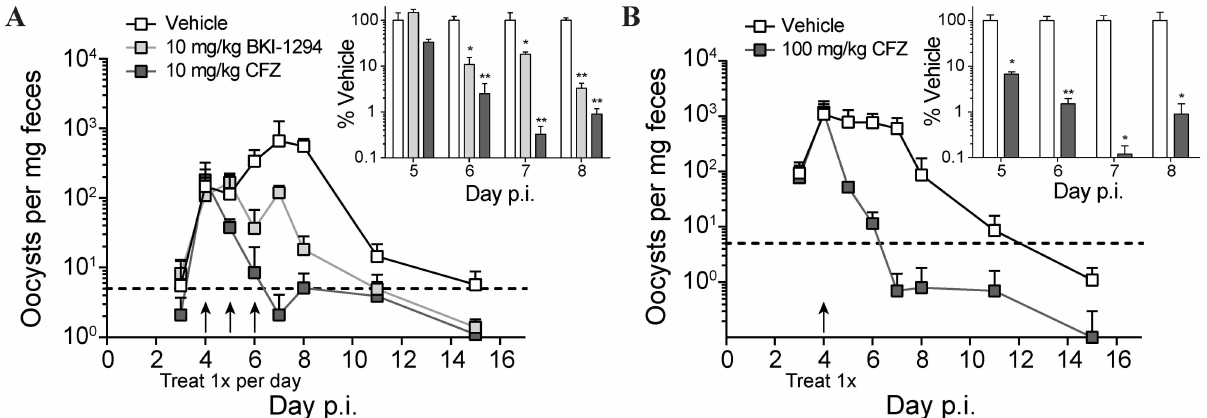
Fig 6. CFZ is efficacious in a mouse model of acute cryptosporidiosis. Fecal oocyst recovery from IFN- γ -/- mice commenced three days after oral delivery of C . parvum oocysts. Line graph data are weight-adjusted mean oocyst counts ± SD (n = 4); inset bar graphsare mean % recovery relative to mock-treated control mice ± SEM (n = 4). (A) Mice were infected with 10 4 oocysts then treated orally with 10 mg/ kg BKI-1294 (light gray) or CFZ (dark gray) on days 4, 5, and 6 p.i. Dotted line is the reliablelimit of detection. A two-way ANOVA was conductedto determinesignificance betweenmice treated with compoundvs mice treated with vehicle: * p < 0.05; ** p < 0.01. (B) Mice were infected with 10 6 oocysts then treated orally with a single dose of 100 mg/kg CFZ on day 4. Multiple Student’s t-tests were used to determinesignificancebetweenvehicle-treated and CFZ-treated mice: * p < 0.05; ** p <